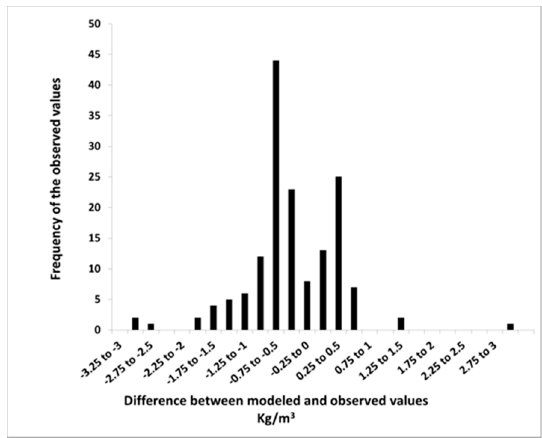
Figure 8. The histogram for the frequency of the modeled and observed concentrations.